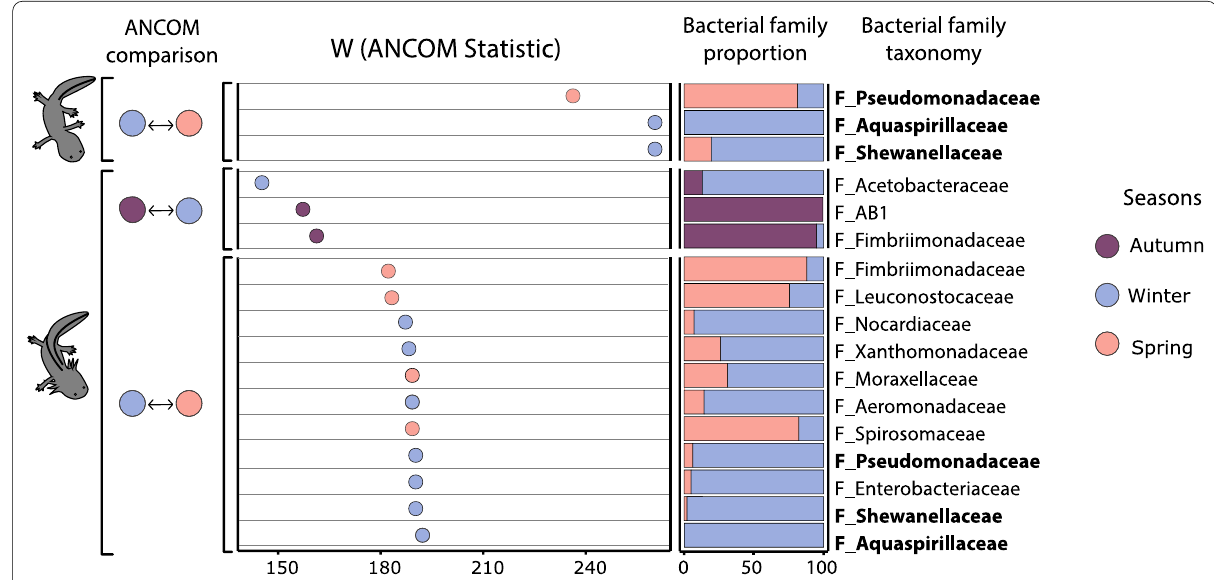
(Fig. 3D, Additional file 2: Table S7), but not dispersion (PERMUTEST, F 1.4, p -value 0.24, df 3) (Additional = = = file 2: Table S8) of metamorphic axolotls. Seasonality also influenced skin bacterial community composition (PER- MANOVA, pseudo-F 15.69, p -value < 0.001, df 3) = = (Fig. 3E, Additional file 2: Table S9) of pre-metamorphic axolotls, in addition we found that dispersion signifi- cantly differed between seasons (BETADISPER, F 2.7, = p -value 0.038, df 3) (Additional file 2: Table S10). = =